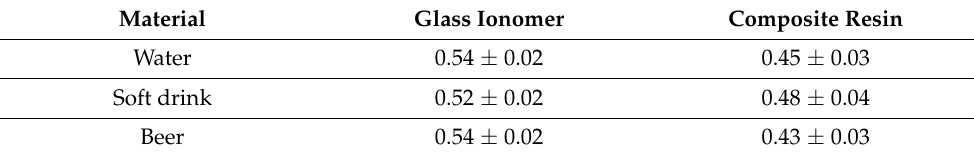
Table 3. Weight measurements